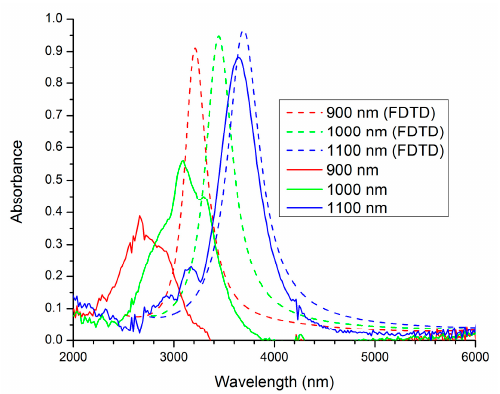
Figure 4. Expected and measured the absorbance of mid-infrared metamaterial absorbers. Finite difference time domain (FDTD) analysis was used to simulate the response of the ideal metamaterials to the incident electromagnetic wave.